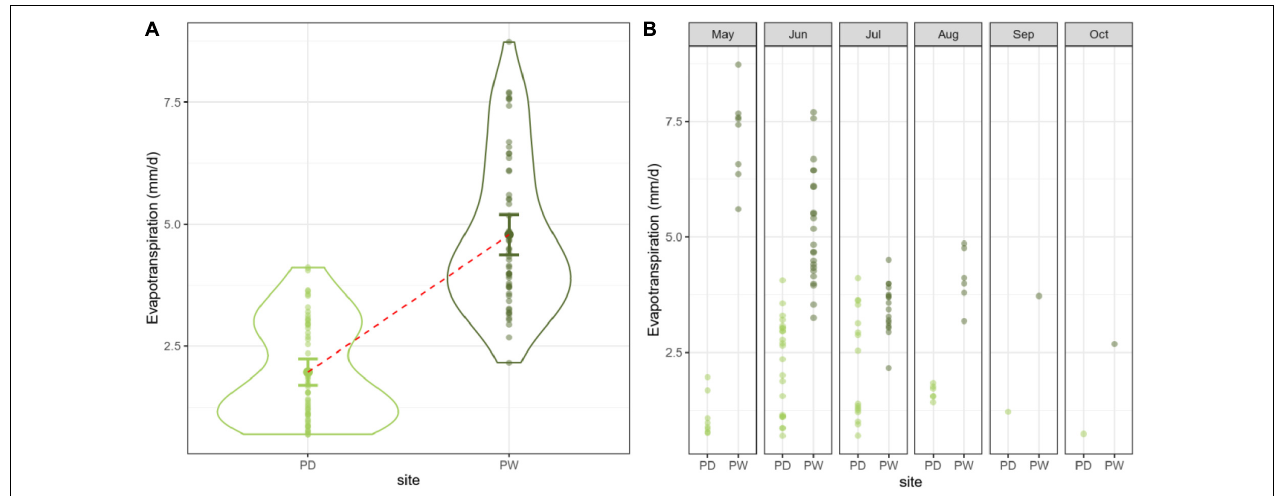
FIGURE 6 | (A) Violin plots of ET with mean and error bars (95% confidence interval). The red dotted line connects the two means (of PD and PW). The violin shapes show the distribution of the data for each site. (B) Evapotranspiration for both sites according to months (in panels).